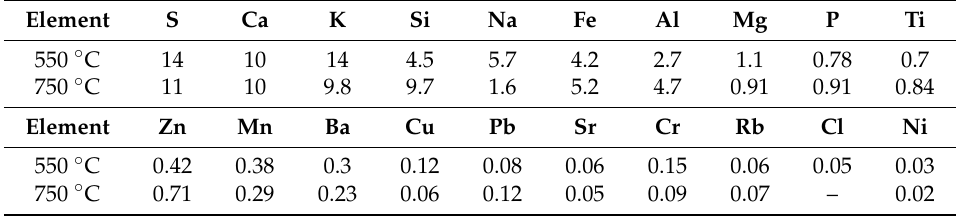
Table 3. Composition of the formed deposits on the probe sections at 550 ◦ C and 750 ◦ C (wt.%).